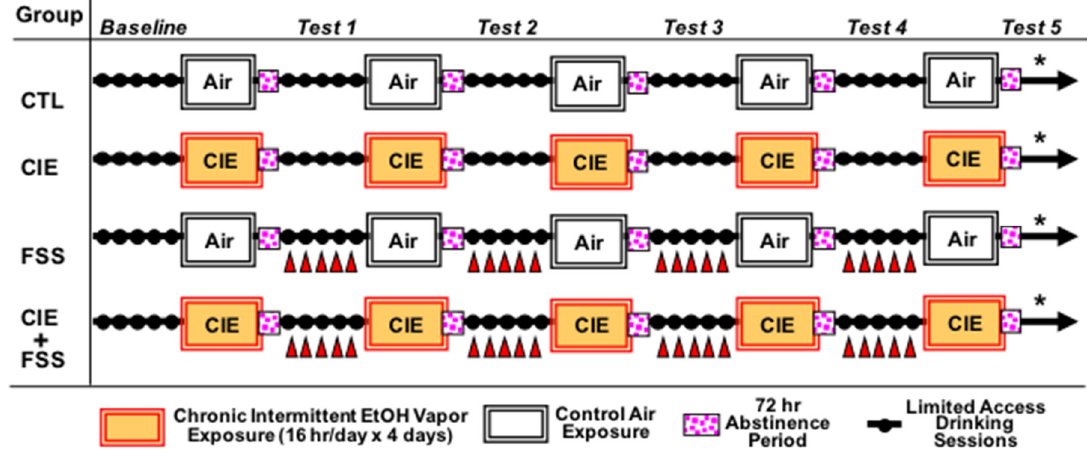
Figure 1. Experimental design for the chronic intermittent ethanol–forced swim stress (CIE-FSS) drinking model. The study design yielded 4 experimental groups: non-dependent alcohol consumption (CTL), CIE, FSS, and CIE + FSS. The “*” represents the time of sacrifice (0-h or 72-h or 168-h) after the last CIE / Air exposure. Only the last 5 days of baseline are represented in this scheme, and the red triangles indicate stress (FSS) exposure. A separate group of naïve mice were sacrificed and used as a common reference for gene expression analysis.